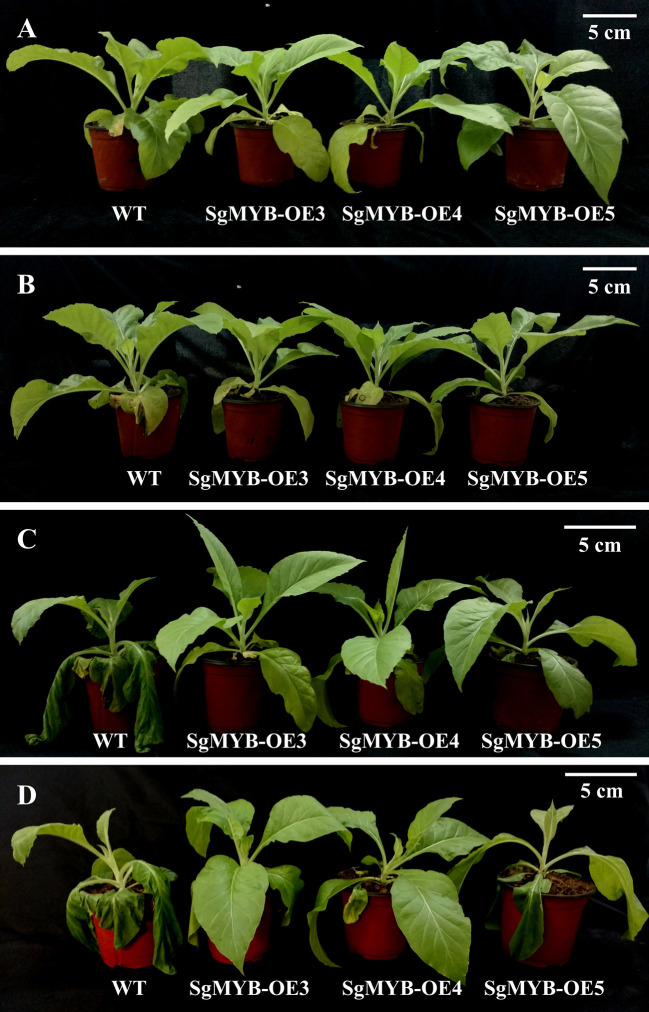
Improved cold tolerance of SgMYB overexpressing transgenic tobacco lines (SgMYB-OE3, SgMYB-OE4 and SgMYB-OE5) compared with wide-type tobacco (WT). All the tobacco plantlets were exposed to cold treatment at 4°C and 70% humidity under a 16/8-h (light/dark) photoperiod. The photos were taken before treatment (A), and after cold treatment of 12 (B), 24 (C) and 48 (D) hours. The white bar stands for 5cm.